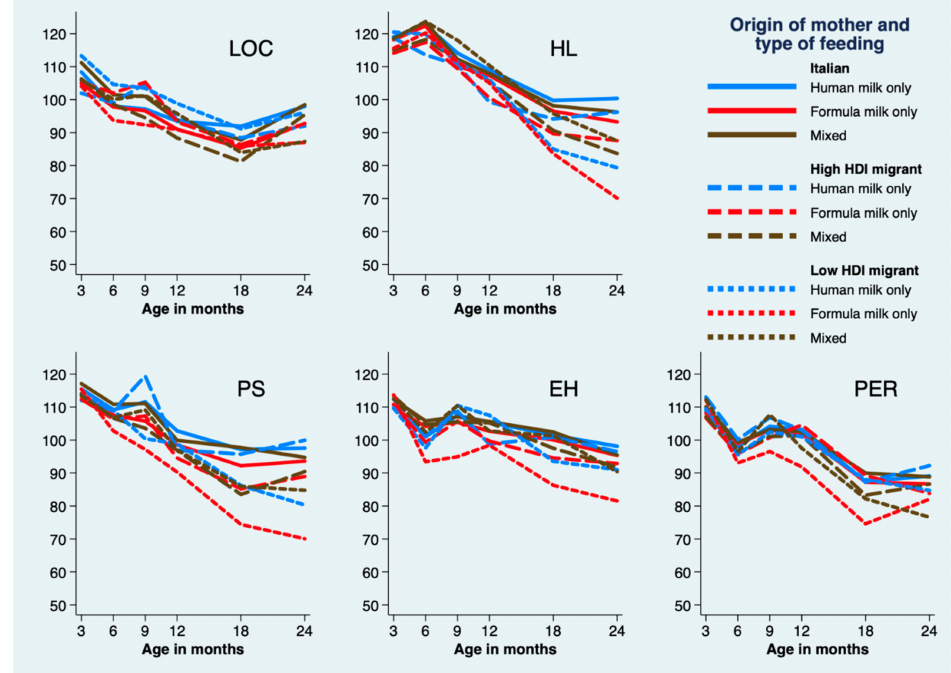
Figure 4. Trajectories of GMDS-R domain subscales estimated by using mixed-effects modeling, by mother’s origin and type of milk feeding and adjusted for mother’s smoking status, and infant IVH / PVL, sepsis, BPD, mechanical ventilation, and SGA at discharge. LOC, locomotor scale; HL, Hearing and Language scale; PS, Personal-social scale; EH, Eye-Hand coordination scale; PER, Performance